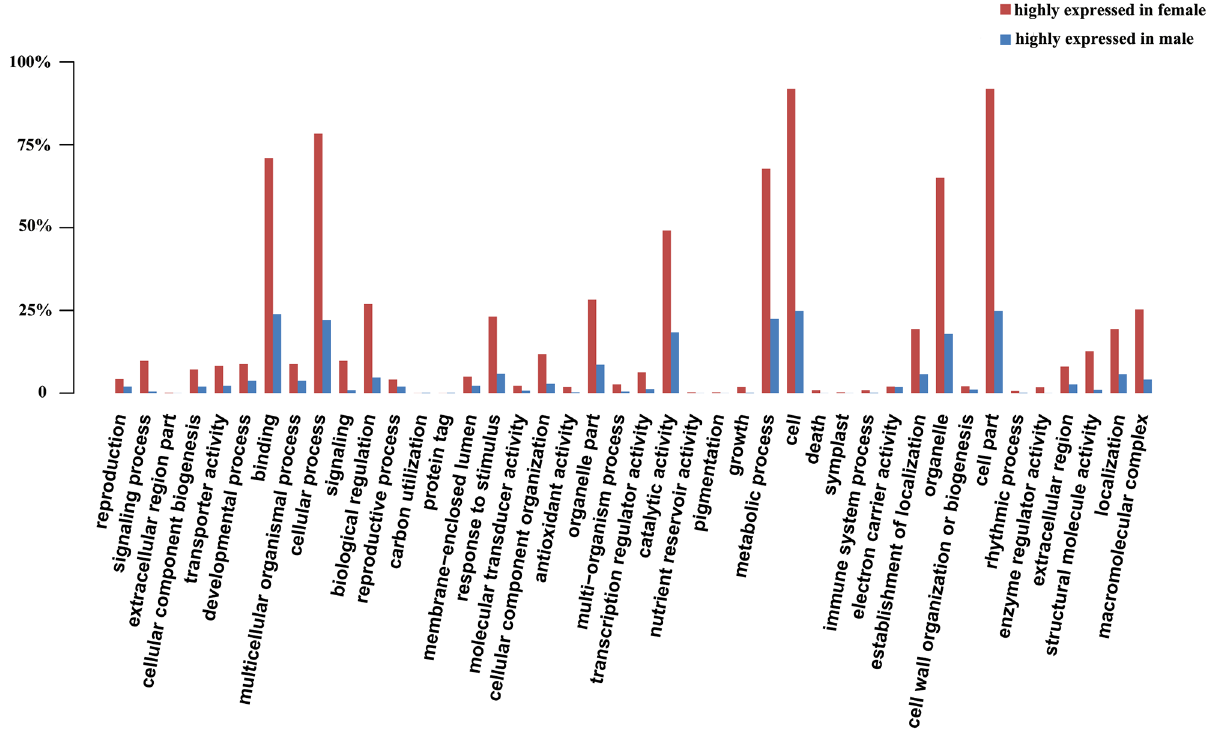
Fig 1. GO analysis for genes differentially expressedbetween female and male flowers.